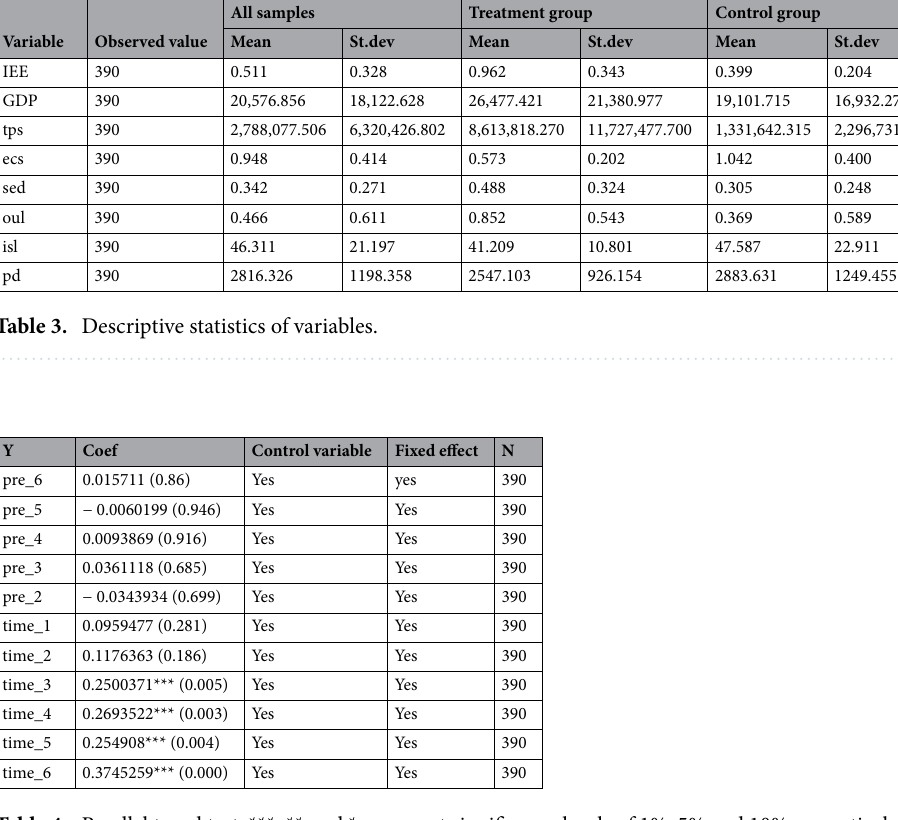
Table 4. Parallel trend test. ***, ** and * represent significance levels of 1%, 5% and 10% respectively, with P values in brackets.